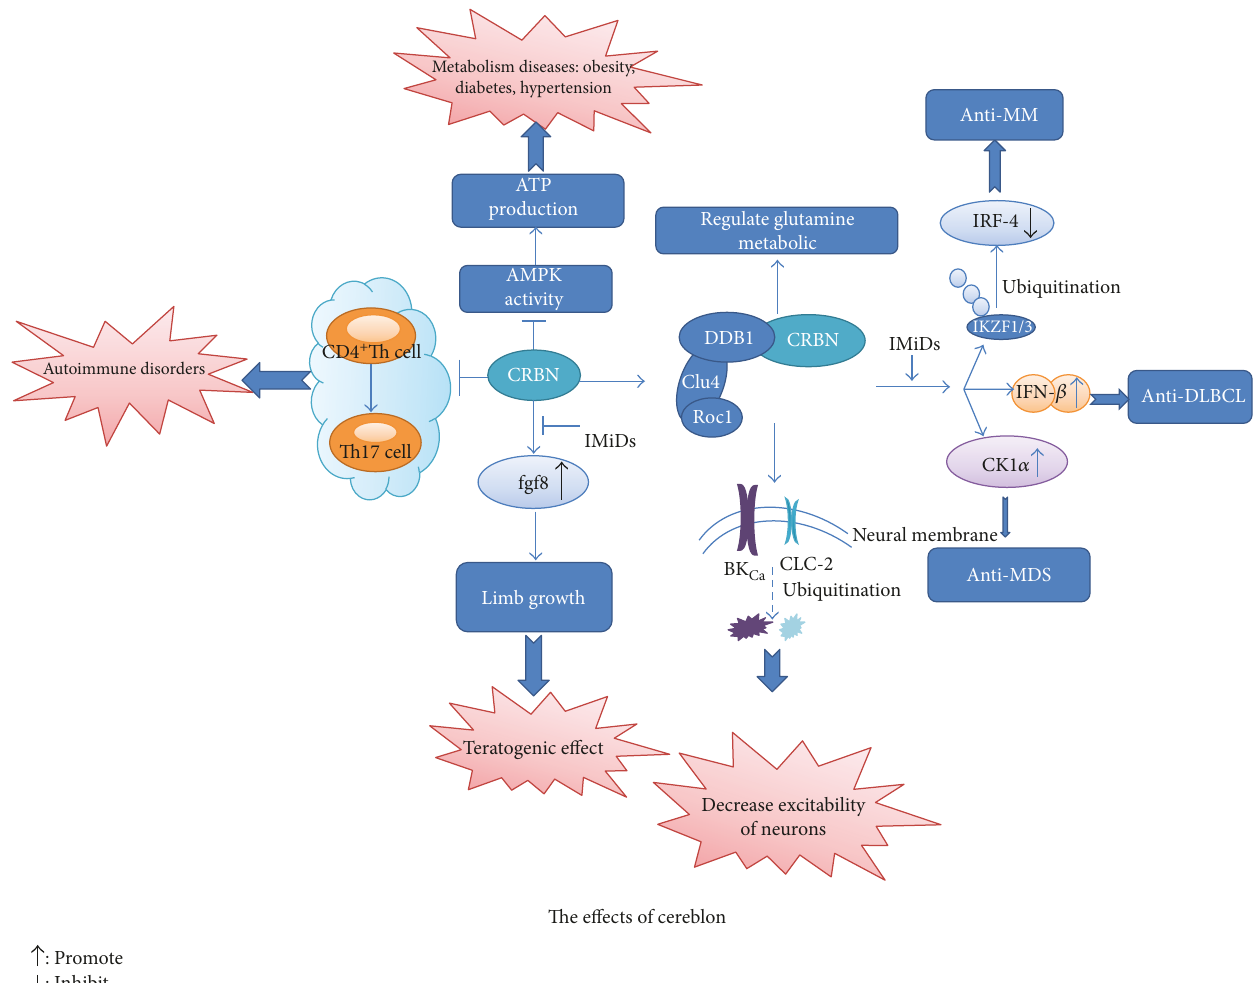
Figure 1: Schematic representation of CRBN-mediated function regulation. In the absence of immunomodulatory drugs (IMiDs), CRBN has an important role in the regulation of ion transport, modulation of AMP-activated protein kinase (AMPK) signaling, and metabolism in cell and whole tissues or organs. In the presence of IMiDs, CRBN is the target protein of IMiDs and helps exert their multiple